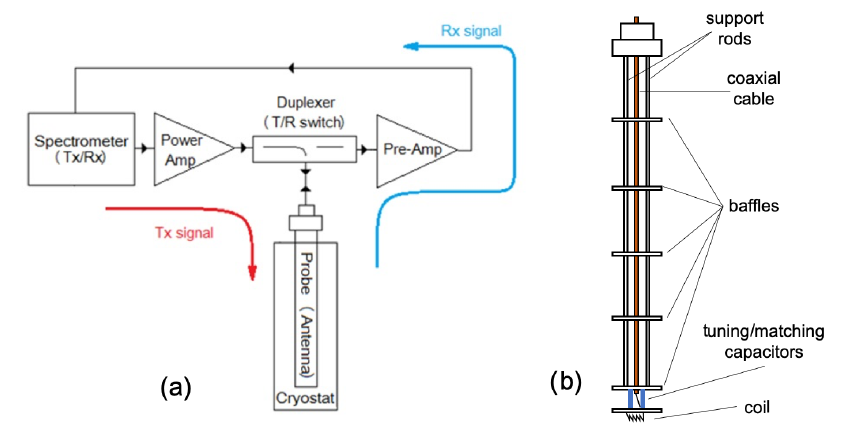
Figure 1. NMR spectroscopy system: ( a ) Basic schematic diagram and ( b ) schematic of the probe used in condensed matter physics (co-axial cable (orange) connected to the coil at the bottom by two variable capacitors (blue)). Thin stainless steel tubes parallel to the cable keep the structure stable, while transverse plates block external radiation from reaching the coil